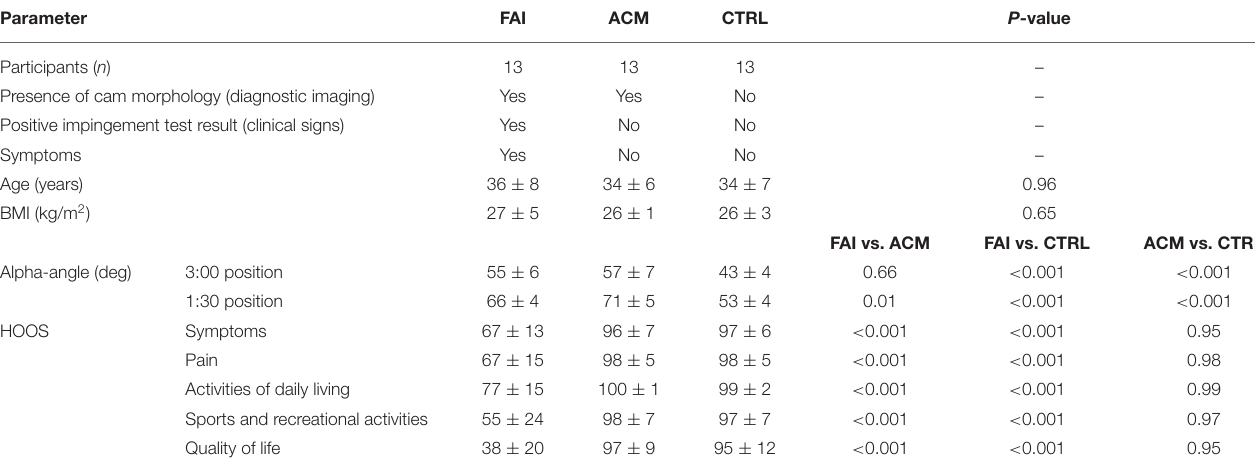
TABLE 1 | Summary of demographics, cam morphology measurement of the affected hips, and pain questionnaire, reporting mean ± SD. Parameter FAI